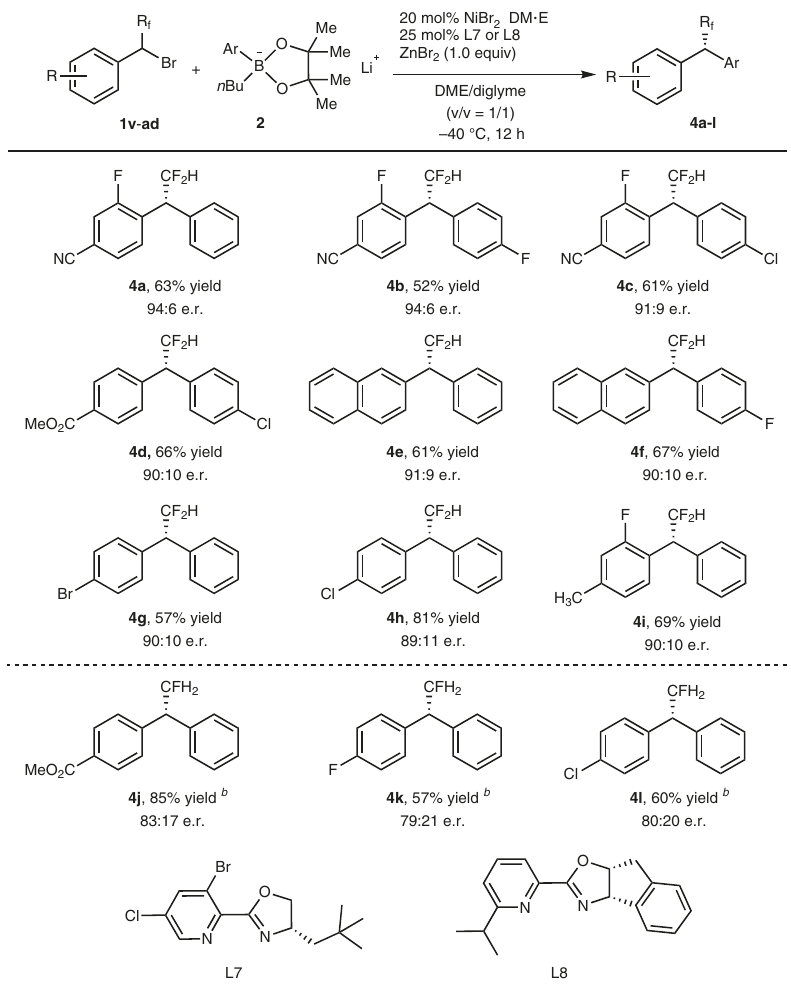
Fig. 6 Substrate scope for reactions with α -bromobenzyl di-/mono- fl uoromethane. All reaction were conducted with compound 1 (0.3 mmol), phenylboronic pinacol ester 2 (0.9 mmol), NiBr 2 (cid:129) DME (20 mol%), ligand L7 or L8 (25 mol%) and ZnBr 2 (0.3 mmol) in DME/diglyme ( v / v = 1/1) at − 10 or − 40 °C for 12 h. Isolated yields and e.r. was determined by chiral HPLC